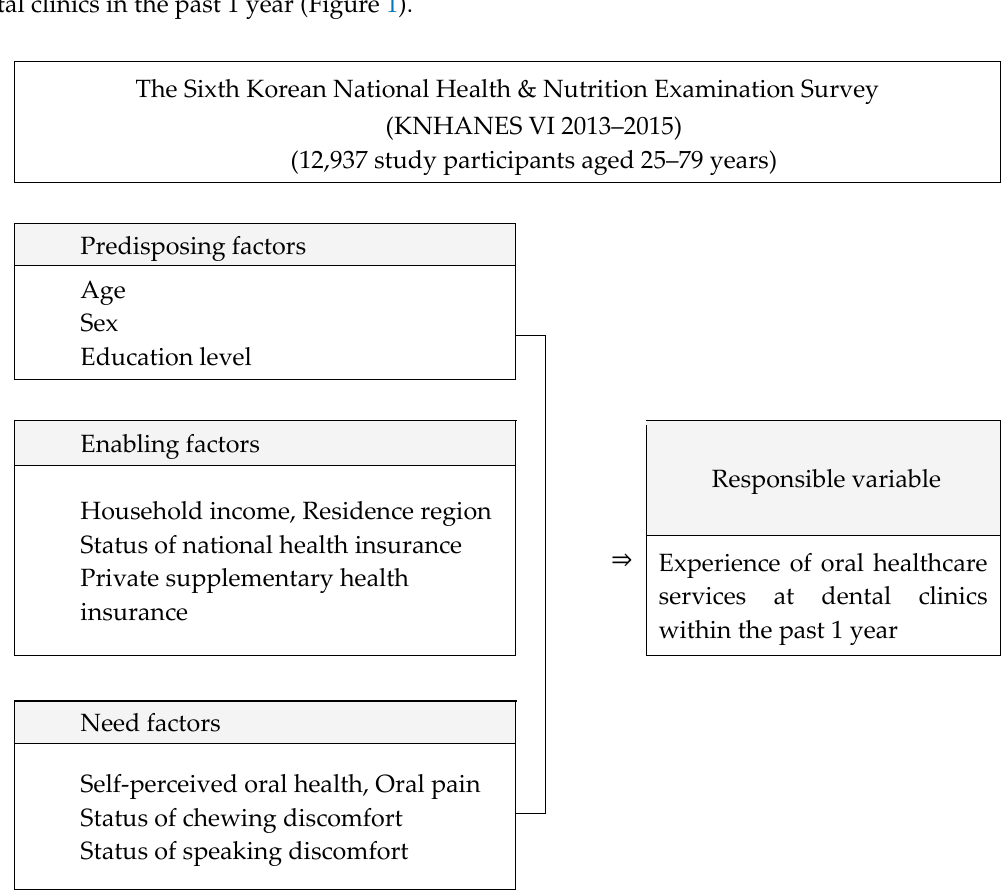
Figure 1. Variables of the study and the analysis process.